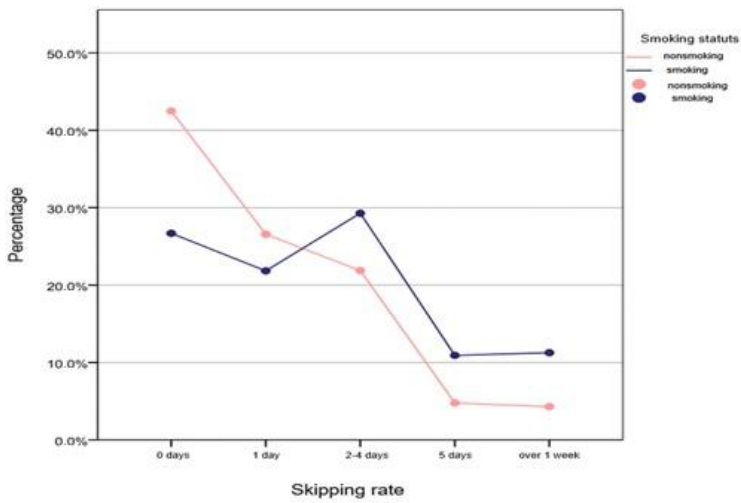
Figure 1. Percentage distribution of students in function of the number of days skipped and smok- ing.